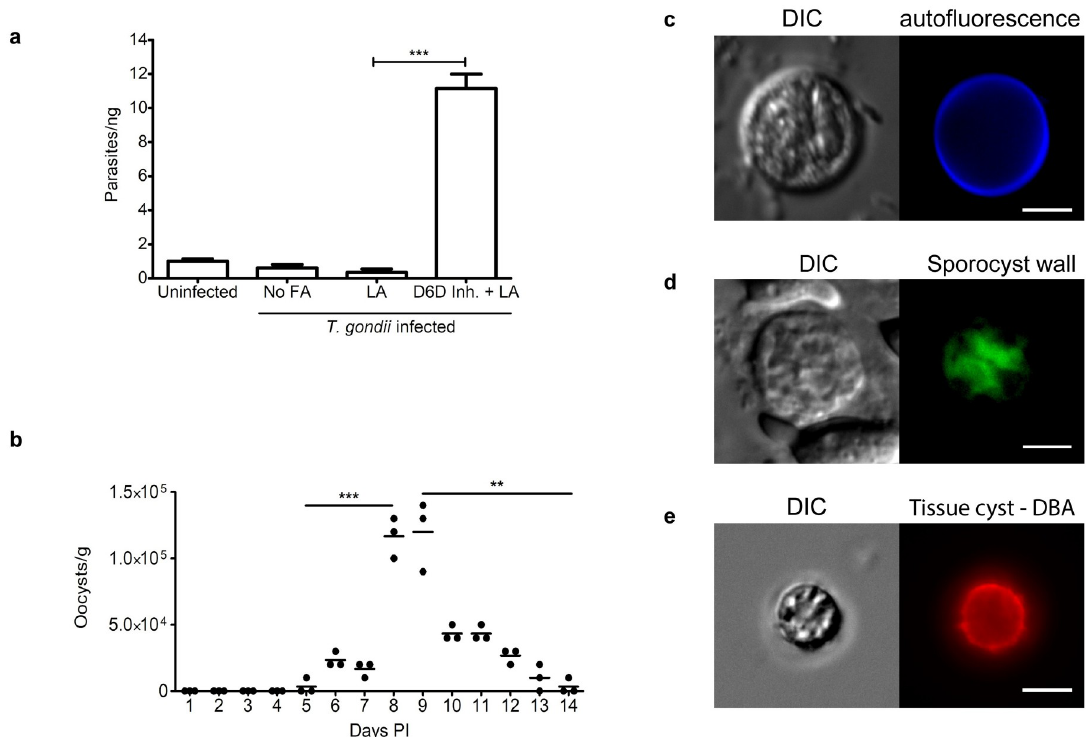
Fig 6. Mouse oocysts are infectious. (a) qPCR on genomic DNA from mouse fecal samples shows that T . gondii genomic DNA is detected only in mice treated with SC-26196 ( p -value = 0.0002 with N = 3 by two-tailed unpaired t test). (b) Counts of the number of oocysts/gram of feces over time. ��� p -value = 0.0003 day 5 versus 8 and �� p -value = 0.0017 day 9 versus 14. (c) After 7 days in sporulation conditions, sporocysts were visible by DIC, and blue autofluorescence of the oocyst walls was enhanced. All panels are 20 μ m 2 with a 5- μ m white size bar in the lower right corner. (d) To expose the sporocyst wall to the 4B6 antibody [11], the sporulated oocysts were dried to the slides, fixed and permeabilized with cold acetone for 30 minutes, incubated with mouse monoclonal antibody 4B6 overnight, and then incubated with goat anti-mouse Alexa Fluor 488 secondary antibody. (e) At 28 days PI with oocysts, T . gondii cysts were purified from the brains of mice and detected by DBA [28] (red). All panels are 20 μ m 2 with a 5- μ m white size bar in the lower right corner. D6D Inh., delta-6-desaturase inhibitor; DBA, Dolichos biflorus agglutinin; DIC, differential interference contrast; FA, fatty acid; LA, linoleic acid; PI, post infection; qPCR, quantitative